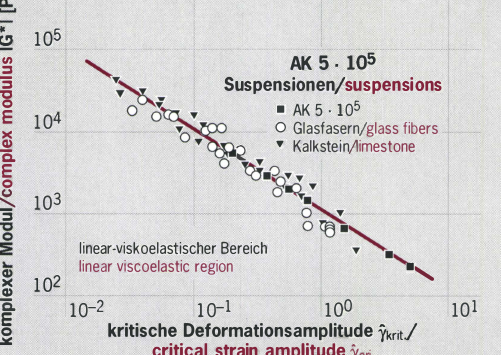
Fig. 11: Flow functions of silicone oils exhibiting viscous